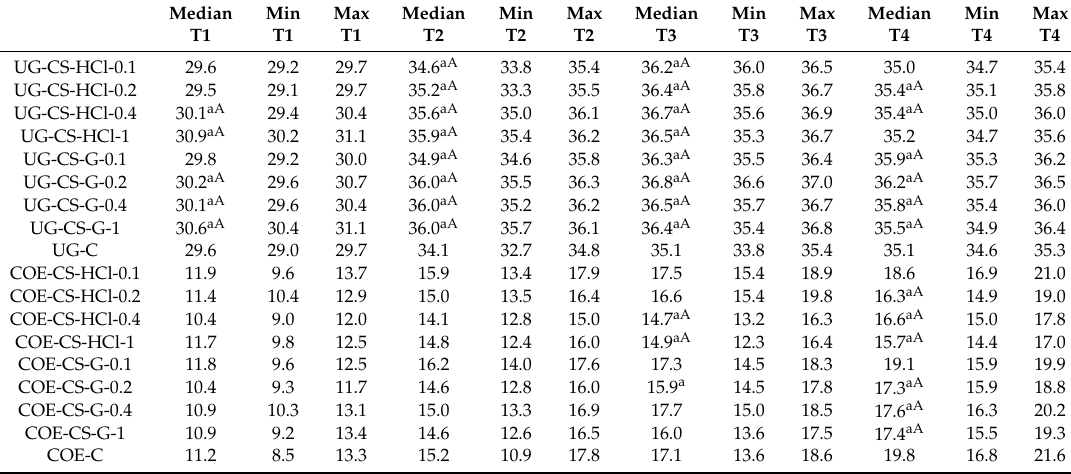
Table 1. Descriptive data for Shore A hardness.